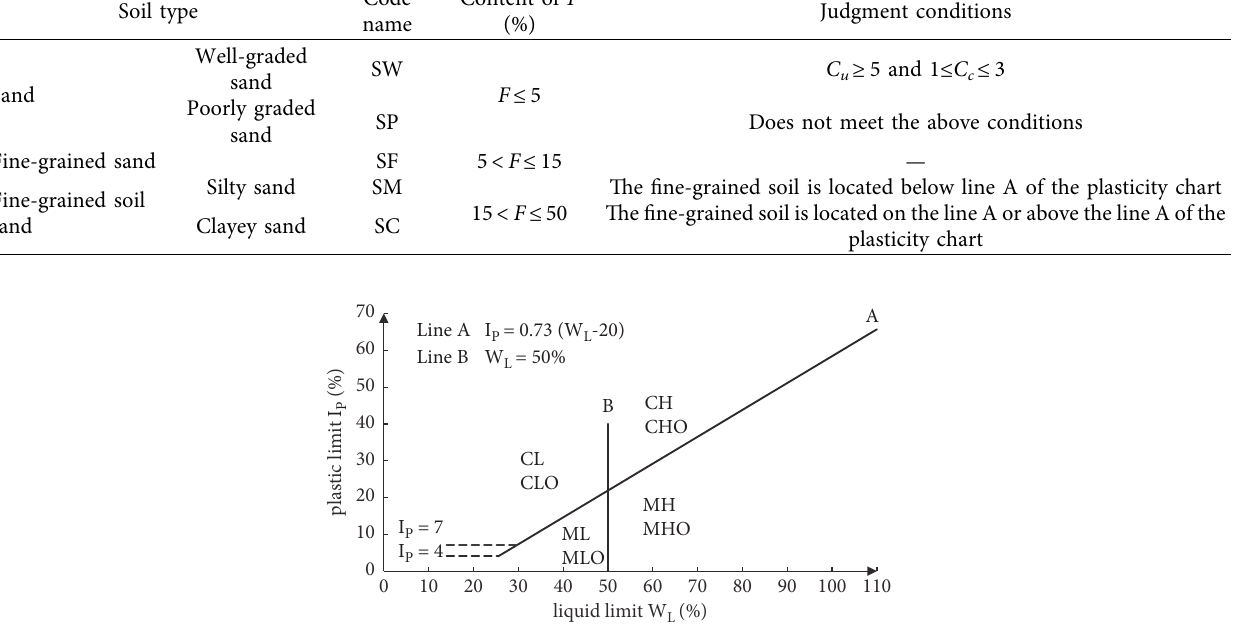
L < 50%; high liquid limit (H): W L ≥